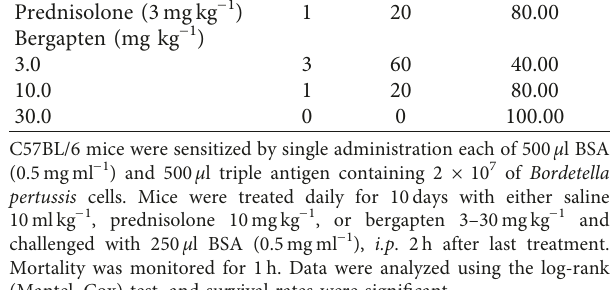
No. of % Survival deaths mortality